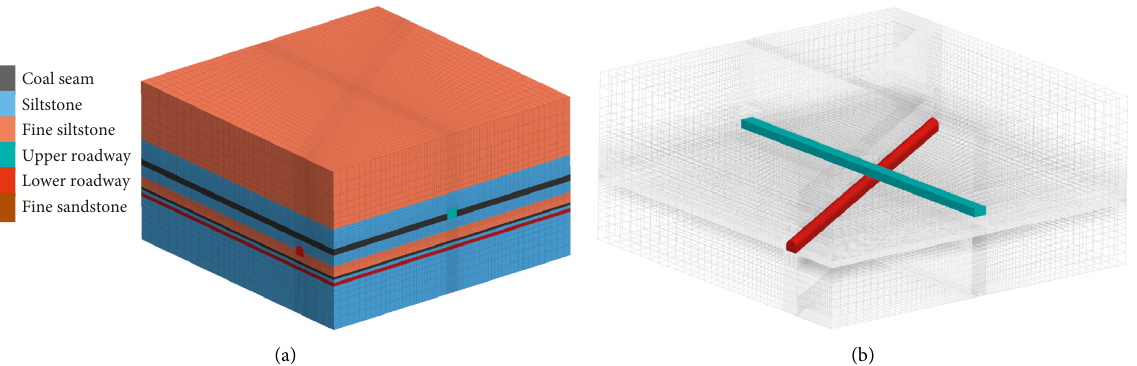
Figure 2: Calculation model (a) 3D model and (b) staggered roadways